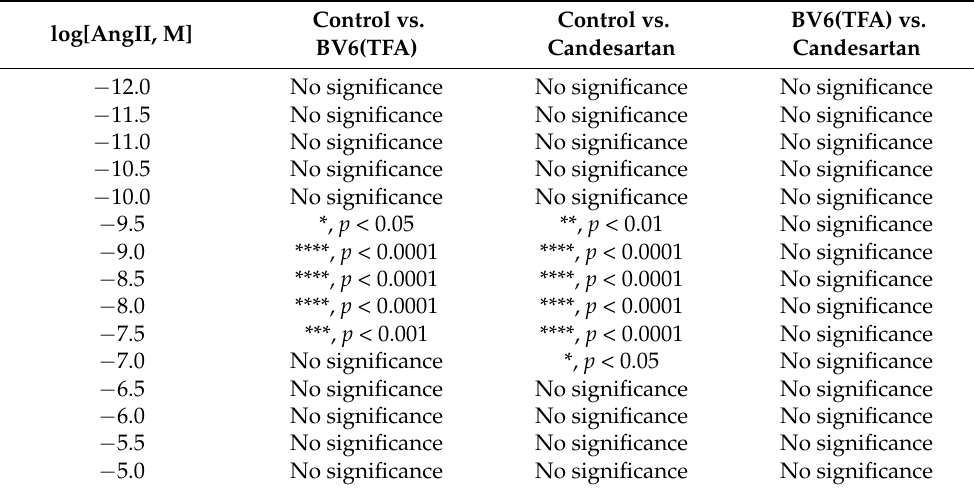
Figure 8. Inhibitory effect of BV6(TFA) and candesartan on angiotensin II-mediated vasoconstriction responses in rabbit iliac arteries. To determine the ability of BV6(TFA) to behave as an ARB, like candesartan, rabbit iliac arteries were incubated and then constricted using cumulative doses of Ang II. Candesartan and the novel bisartan BV6(TFA) were able to potently inhibit vasoconstriction responses to Ang II at doses [10 − 9.5 M] to [10 − 7.5 M] (mean ± SEM is shown; significance is presented in Table 3). Table 3. Significance of vasoconstriction in response to cumulative doses of angiotensin II between control, candesartan, and Bv6(TFA) incubations obtained from Figure 8.